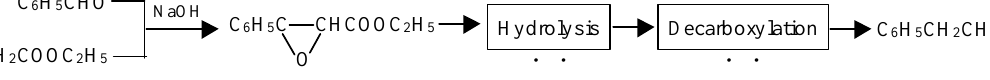
SO concentration. In 2 4 SO 2 4